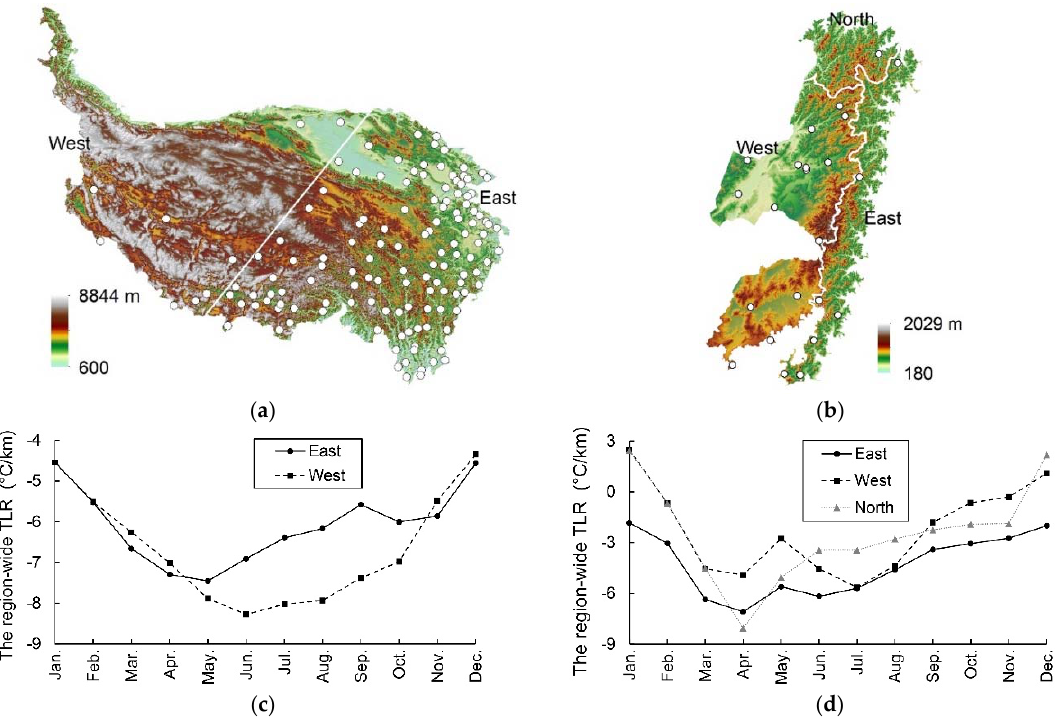
Figure 6. The region-wide monthly average TLR of the Tibetan Plateau ( a and c ) and the Greater Khingan Mountains ( b and d ). The white circles in the patches ( a ) and ( b ) represent the ground meteorological stations. The dividing line in patch ( a ) indicates east and west of the plateau with much more stations in the east, and patch ( b ) indicates the mountain ridgeline. The TLR in patches ( c ) and ( d ) are the average of the TLR values of image pixels with - 15 < Γ ≤ 10 °C/km in every month.